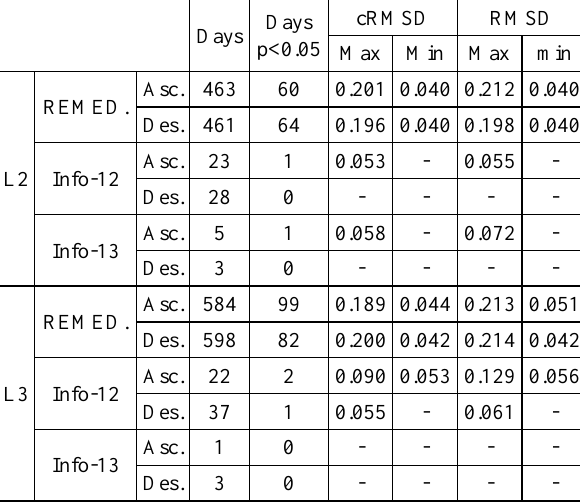
Table 3. Results of the daily validation for the days were the correlation was significant (p-value <0.05) given a threshold of 16 concurrent pairwise observations for